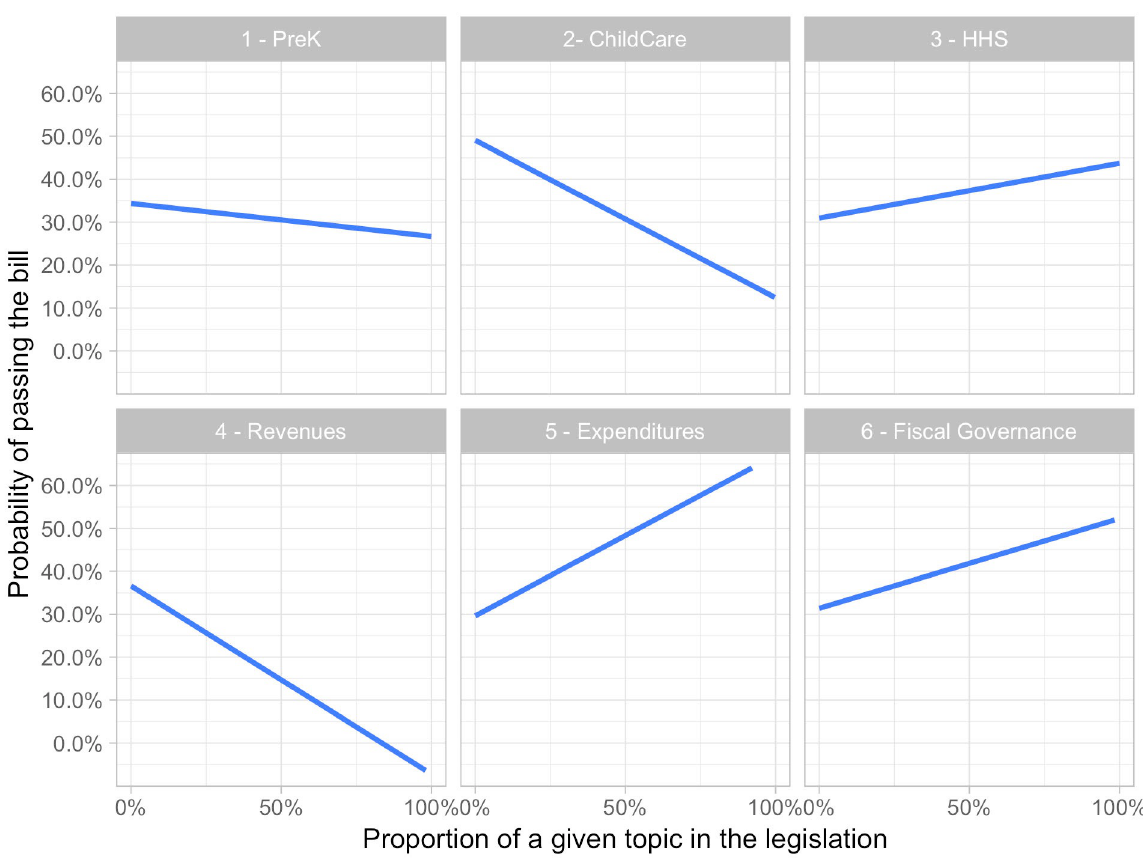
Fig 6. Bivariate association between ‘topics’ (bill content) and the odds of the bill being adopted.